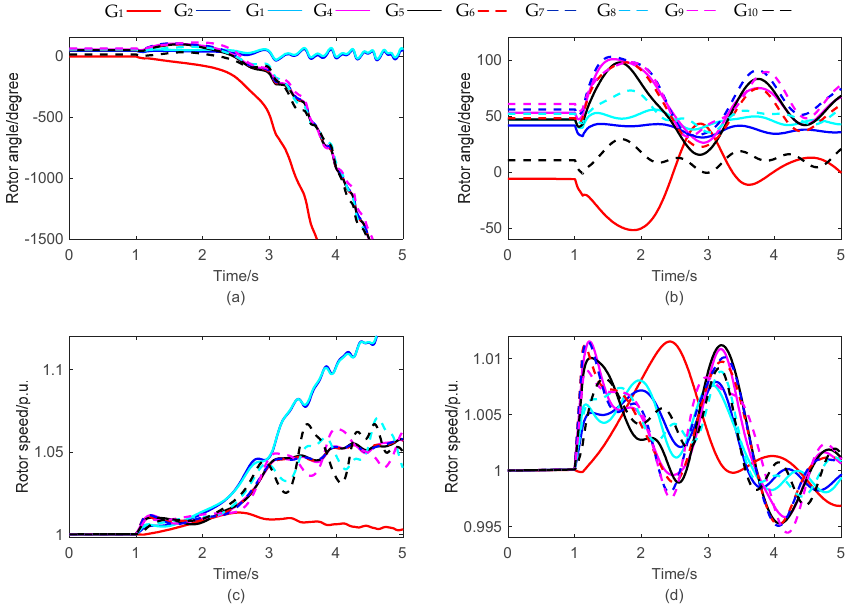
Figure 10. Dynamics of the generator ( a ) rotor angle and ( b ) rotor speed without PEC; Dynamics of the generator ( c ) rotor angle and ( d ) rotor speed with PEC.